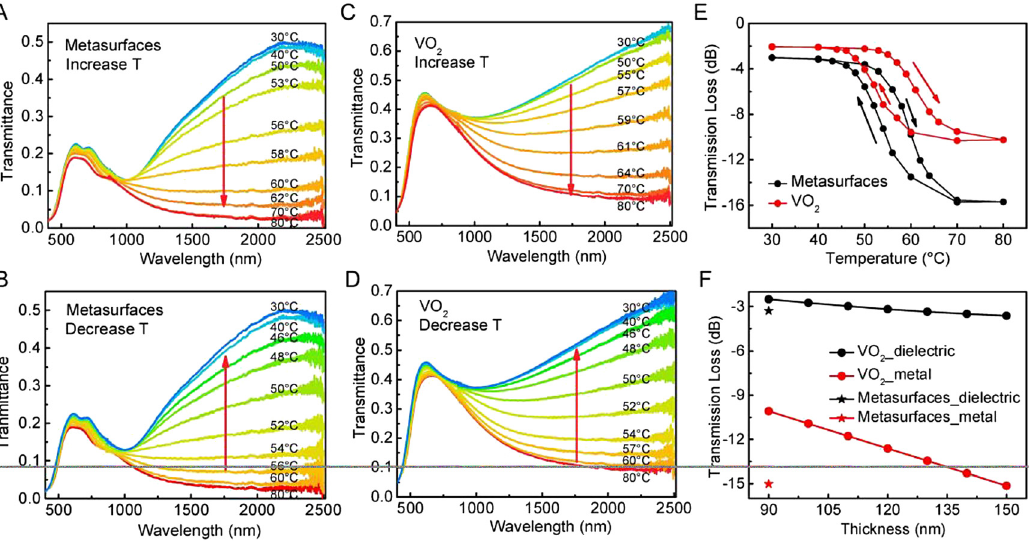
Figure 2: Temperature-dependent transmittance spectra of the metasurfaces for (A) increasing temperature and (B) decreasing temperature, respectively. Temperature-dependent transmission spectra of VO 2 thin fi lms for (C) increasing temperature and (D) decreasing temperature, respectively. (E) Transmittance of the metasurfaces and the VO 2 thin fi lm as a function of temperature at 2200 nm wavelength. (F) Simulated